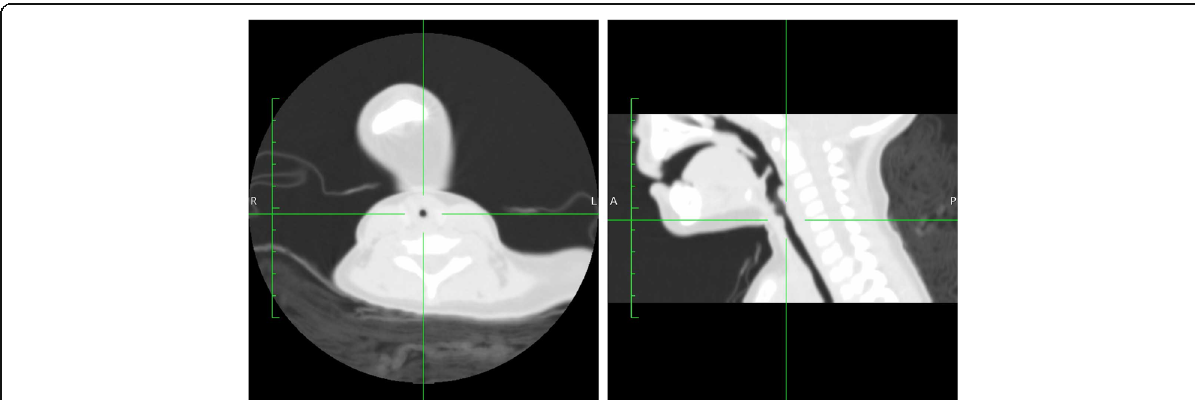
Fig. 3 Neck CT images taken at POD 7. Tracheal stenosis was improved but still existed at the subglottic level. The sagittal plane image demonstrates the process of the anterior wall of the trachea ( arrow in the right panel ). Left , transverse image of the neck. Right , sagittal image of the